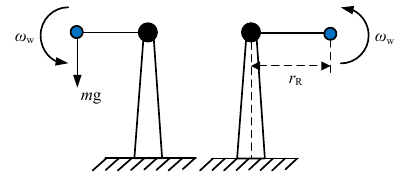
Figure 3. Model of blade mass imbalance.